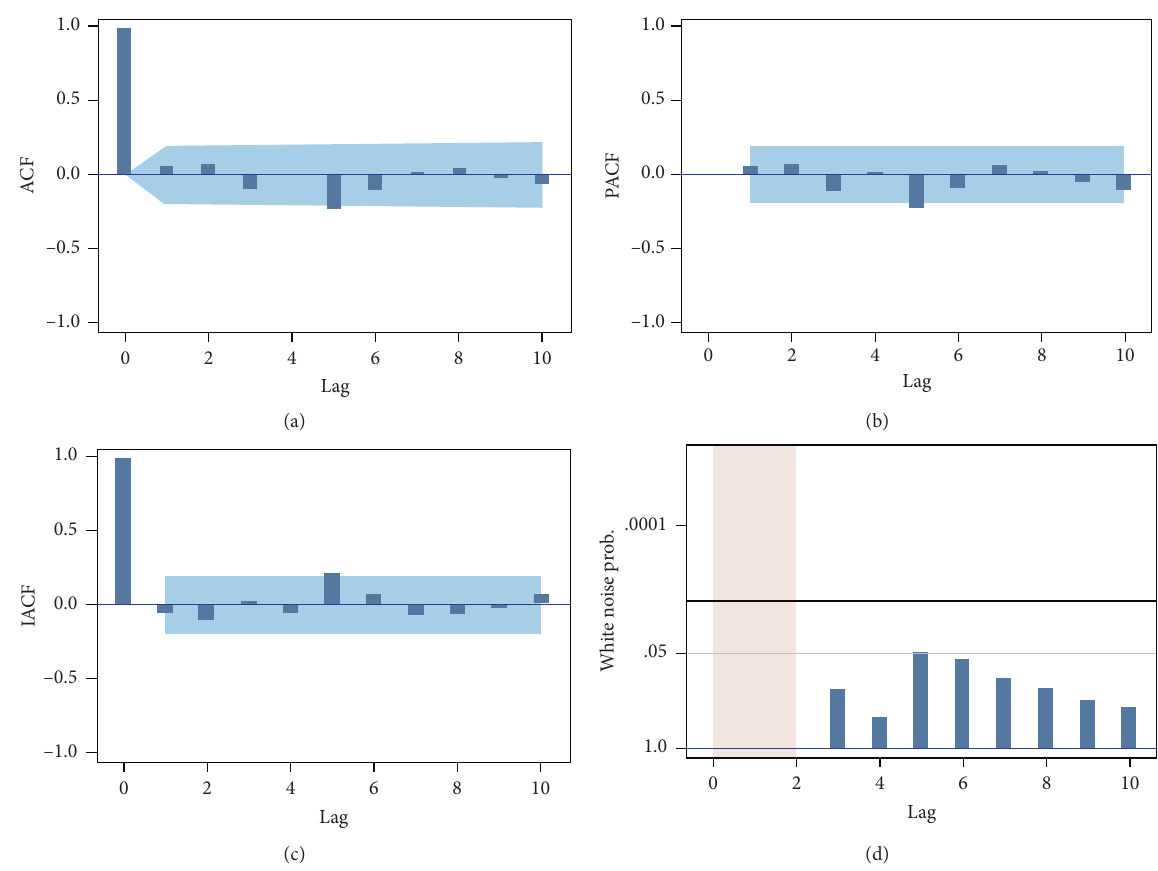
Figure 4: Residual normality test chart of RDL model after green finance correction.